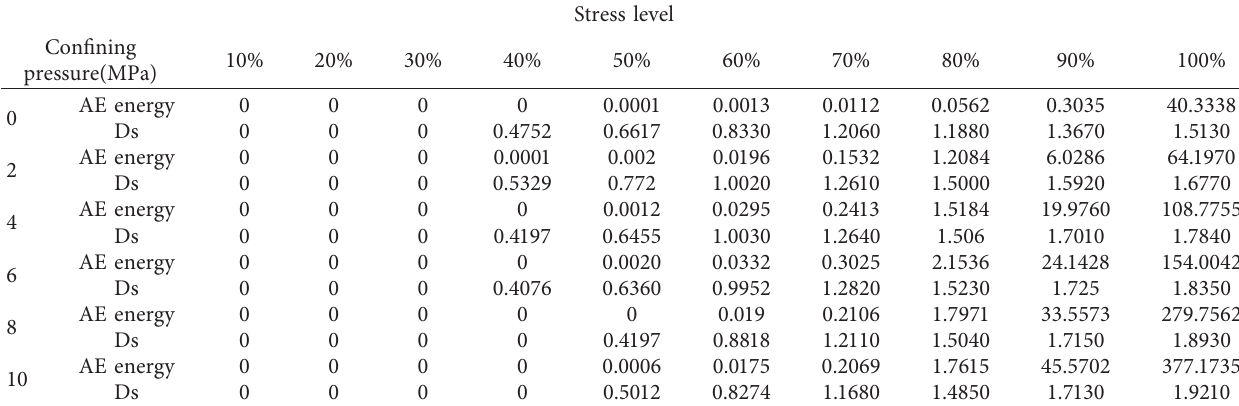
Figure 18: Relationship between stress level, confining pressure, and fractal dimension. Table 3: AE energy and fractal dimension values under different stress levels and different confining